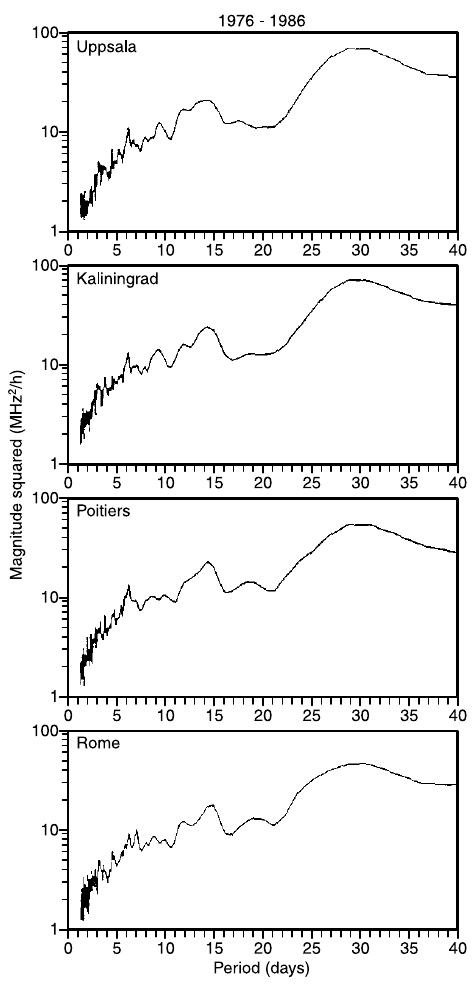
Fig. 12. Averaged periodograms of f periodic range from 30 h to 40 days for the whole solar cycle 21, calculated as a mean of 126 spectra of successive 4-month intervals shifted by 1 month (Apostolov et al .,